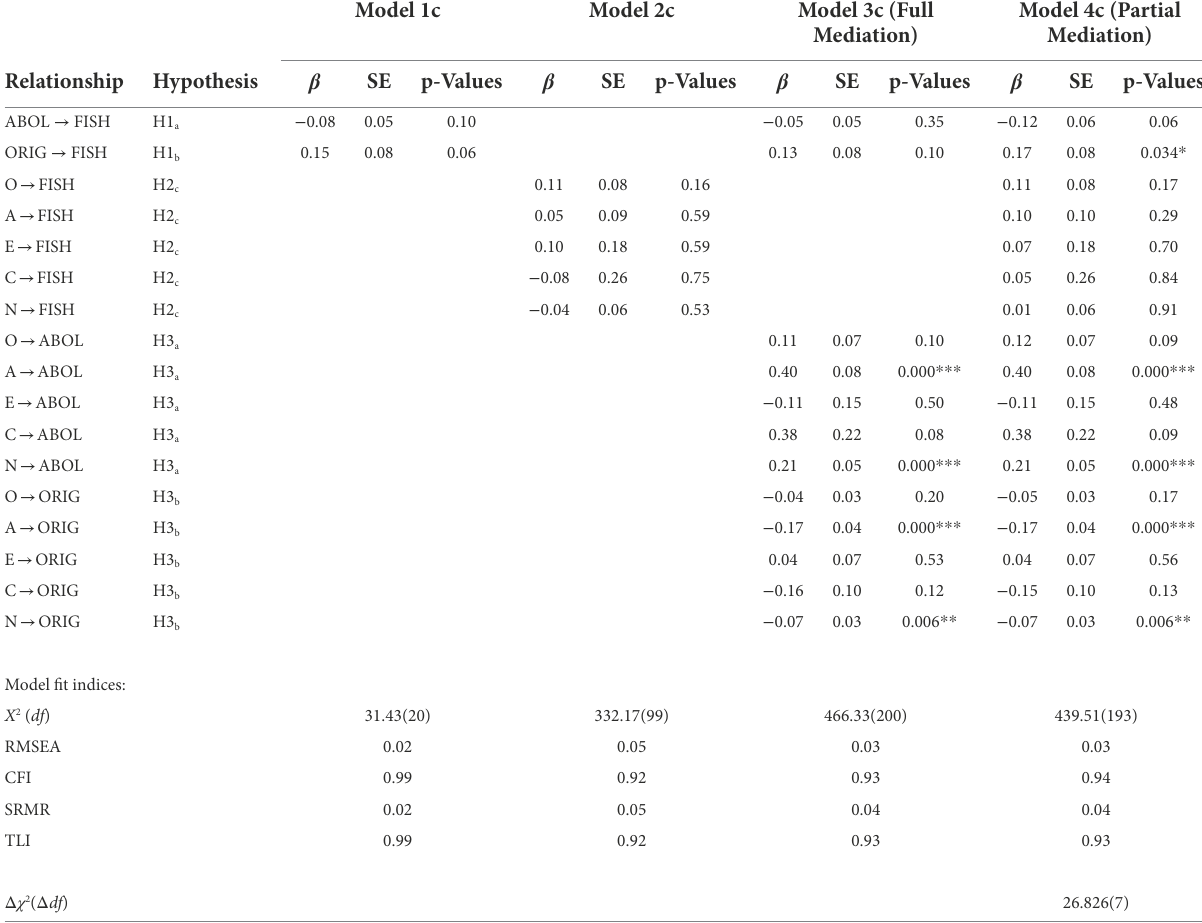
TABLE 4 Fish consumption structural equation models and fit indices, controlling for sex and parental education